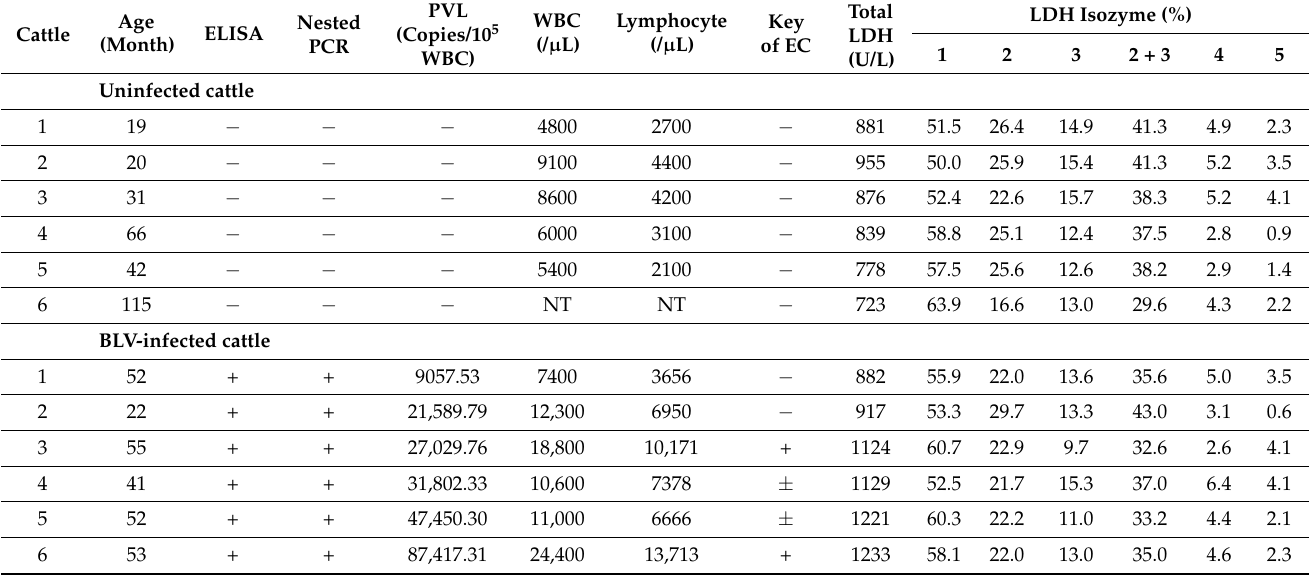
Table 1. Clinical status of the cattle in this